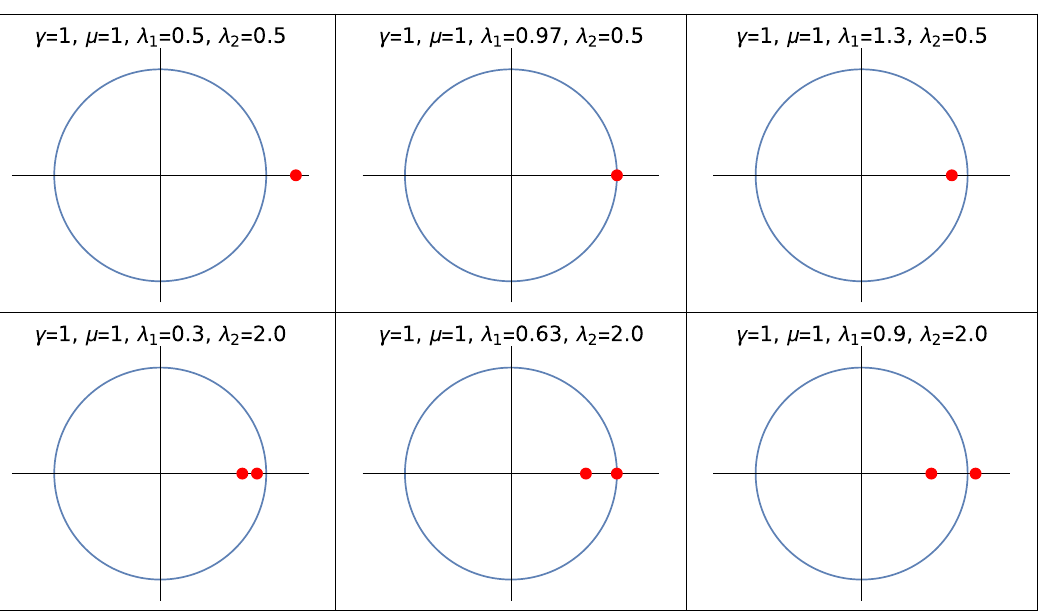
Figure 3. Zeros of a Hamiltonian plotted with respect to a unit circle for the transitions, W = 0 to W = 1 ( (cid:31) 2 = 0.5 ) (upper panel) and W = 1 to W = 2 ( (cid:31) 2 = 2.0 ) (lower panel). Two red dots corresponds to the Value of the roots greater than 1 corresponds to the non-topological phase whereas less than 1 corresponds to topological phase. Transition points p 1 and p 2 marks the transitions between W = 2 to 1 and W = 0 to 1 respectively with fixed positive value of (cid:31) 2 ( (cid:31) 2 = 0.5, 2.0). Keeping track of these transition points via the ZMS method provides the phase diagram of the model Hamiltonian (Fig. 1). The transitions through the curved critical lines in the negative (cid:31) 2 region are analyzed in the further sections. In the Fig. 3 we can see the ZMS plotted with respected to a unit circle whereas the unit circle is made into a unit line in the Fig. 2. The zeros falling inside the unit circle corresponds to the topologically non-trivial phase whereas the zeros falling on the unit circle and outside the unit circle corresponds to the transition and topologi- cally trivial phase respectively. In both Figs. 2 and 3 the same zeros are plotted with respect to a system parameter (cid:31) 1 and a unit circle respectively.